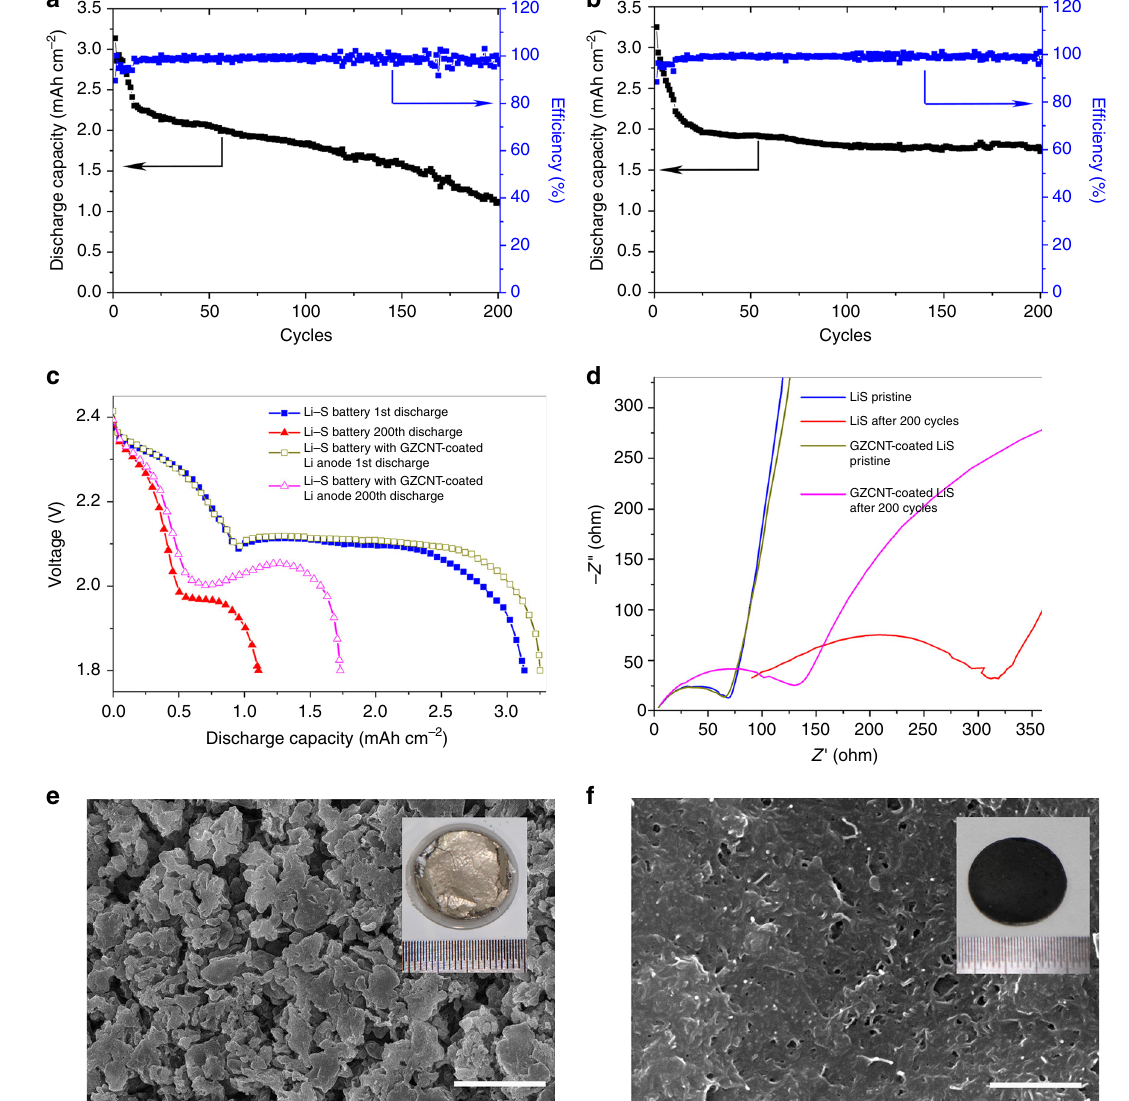
Fig. 9 Electrochemical performance of Li – S batteries with the GZCNT-coated Li foil anode. a – c Charge – discharge properties at 0.2 C (0.6 mA cm – 2 ) with a capacity of up to 3 mAh cm – 2 . Discharge capacity and Coulombic ef fi ciency of Li-S batteries with a a pristine Li foil and b the GZCNT-coated Li foil anode, and c charge and discharge curves of pristine and after-200-cycle Li – S coin cells. d Electrochemical impedance spectra of pristine and after-200-cycle Li – S coin cells assembled from blank and GZCNT-coated Li. Frequency: 0.1 Hz – 1 MHz, perturbation amplitude: 5 mV, measured at 100% SOC. e , f Top-view SEM images of the blank ( e ) and GZCNT-coated Li foils ( f ) from Li – S coin cells after 200 cycles. The insets show the digital photos of the corresponding Li anodes without ( e ) and with ( f ) GZCNT interfacial layers after 200 cycles. Scale bar, 5 μ m for e and 1 μ m for